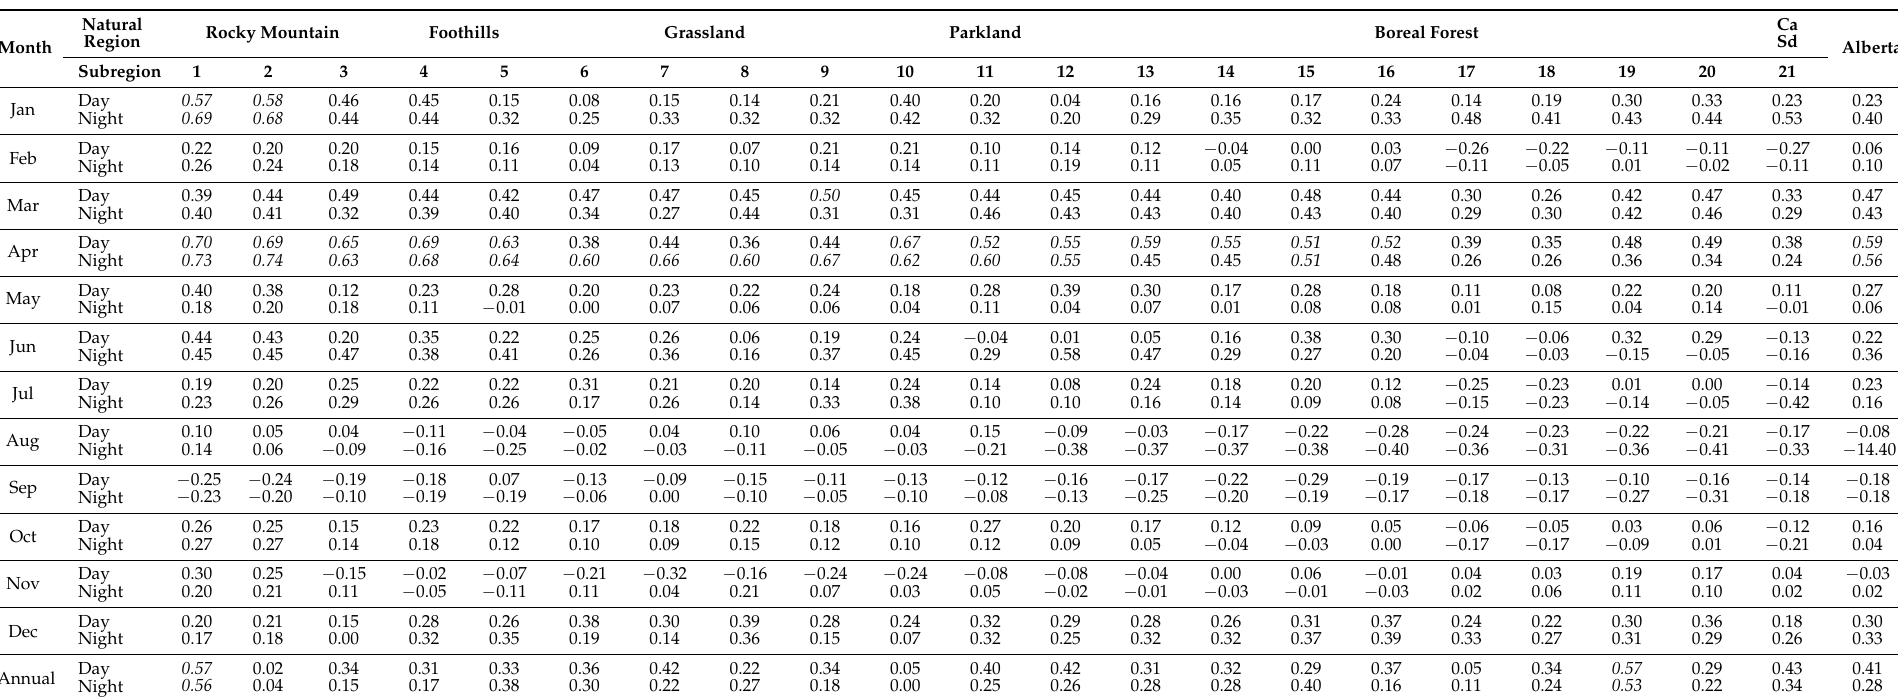
Table 5. Relations between day and nighttime LST and PDO indices at both monthly and annual timescales, where acceptable correlations ( r ≥ 0.50) are highlighted